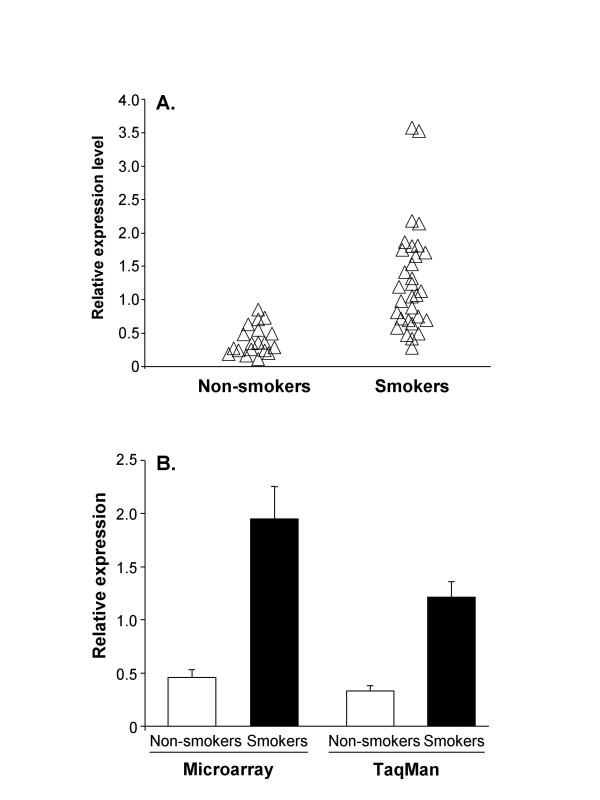
Mean RNA expression levels for pirin in smokers and non-smokers A. Microarray relative expression values (non-smokers n = 9, smokers n = 13, right and left lung samples for each individual). The relative expression level for pirin represents the normalized expression level in each array divided by the median expression level for pirin in all 44 microarrays. B. Comparison of microarray and TaqMan relative expression values (nonsmokers n = 3, smokers n = 9). Shown are the mean expression level of pirin ± standard error in airway epithelium of nonsmokers and smokers quantified by either microarray (p < 0.01) and TaqMan (p < 0.01).